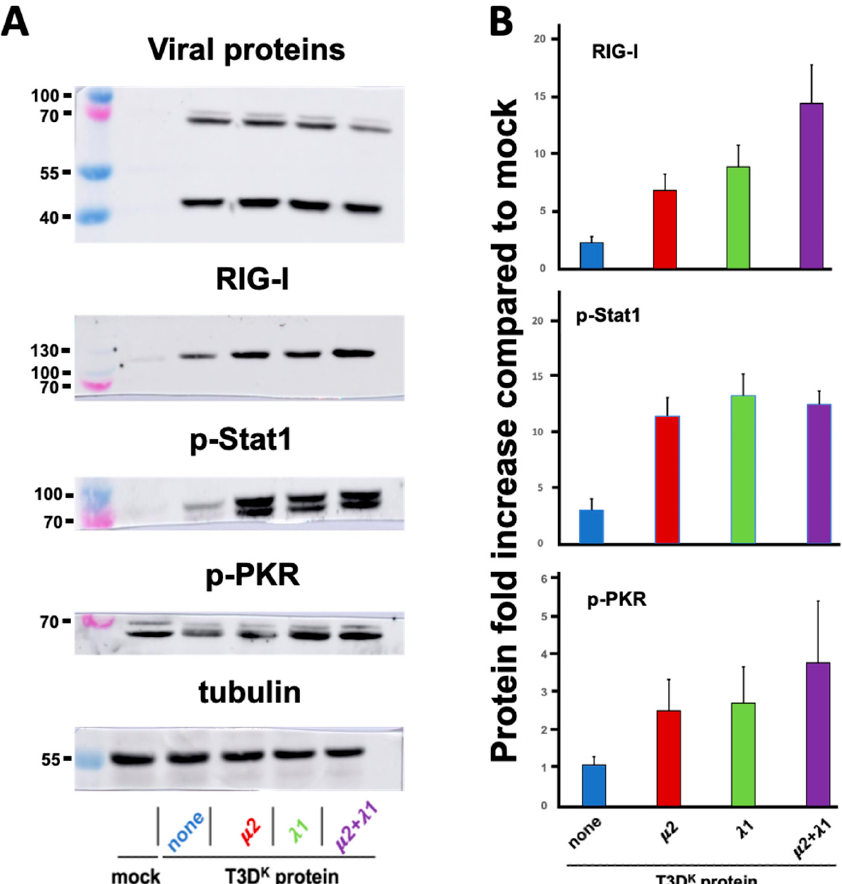
Figure 3. Increased levels of various proteins along the interferon signaling network. L929 cells were either mock-infected or infected at a MOI of 10 TCID 50 units per cell with the T3D S virus or the T3D S virus harboring the μ 2, λ 1 or both μ 2 and λ 1 of T3D K in the T3D S background, as indicated; again, none refers to the T3D S virus with no T3D K proteins substituted. Cells were incubated for 15 h before being recovered and the different proteins analyzed by immunoblotting, as described in Materials and Methods, using antibodies listed in Table 1. ( A ) Representative immunoblots of two or three independent biological replicates are presented. In each case, viral proteins were also immunodetected using a combination of monoclonal antibodies against viral proteins σ 3 at a predicted molecular weight of 41 kDa and μ 1, detecting the μ 1C protein cleavage at a predicted molecular weight of 72 kDa. A control for loading using tubulin was also used. ( B ) Quantitation of the replicates (three or four) is presented. For each replicate, the value of mock-infected cells was fixed as “one” and all samples were adjusted accordingly, taking into account small differences in the values of tubulin. Molecular weight standards in kilodaltons are indicated on the left of each panel. All data are presented as the means with error bars representing the standard error of the mean.